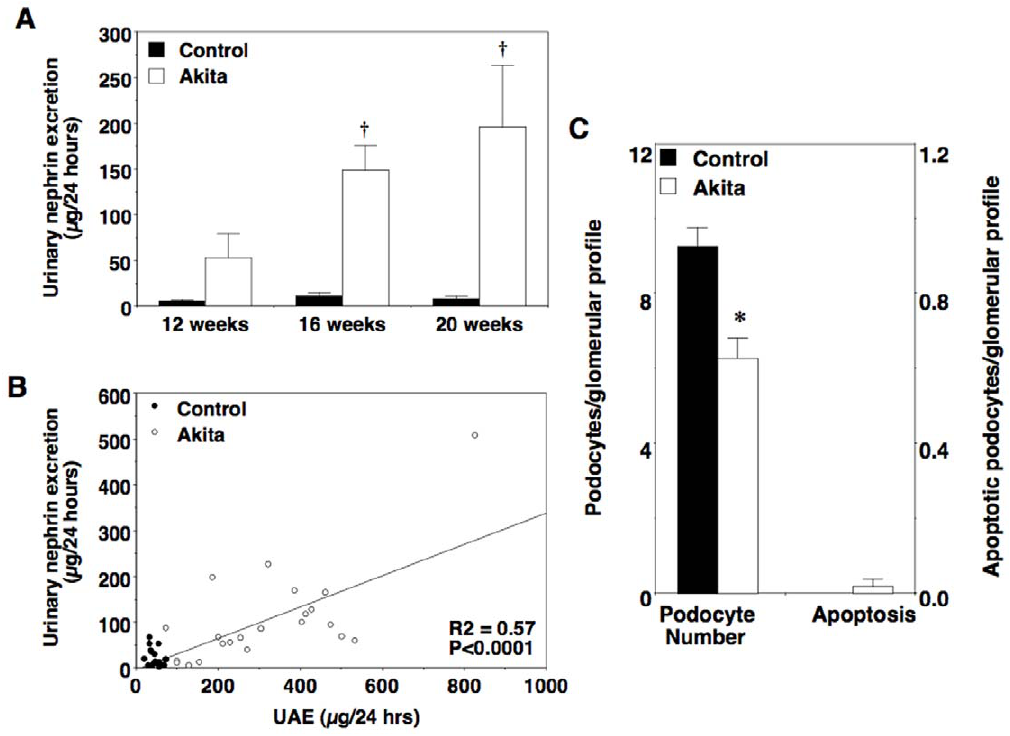
Figure 5. Podocyte injury in albuminuric diabetic Akita mice. (A) Urinary nephrin excretion was significantly enhanced in Akita mice compared to controls at 16 and 20 weeks of age. (B) There was a significant linear relationship between urinary nephrin excretion and albuminuria in all mice (R 2 =0.57; P , 0.0001). (C) Podocyte number was significantly decreased in Akita mice at the 20-week time point. In contrast, podocyte apoptosis was difficult to detect in either Akita mice or control animals. Black bars=control (n=6 to 8); white bars=Akita (n=6 to 8). Black circles=control; white circles=Akita. Data are mean 6 SEM. *P , 0.05 or { P , 0.01 vs. age-matched controls. doi:10.1371/journal.pone.0033942.g005 PLoS ONE |